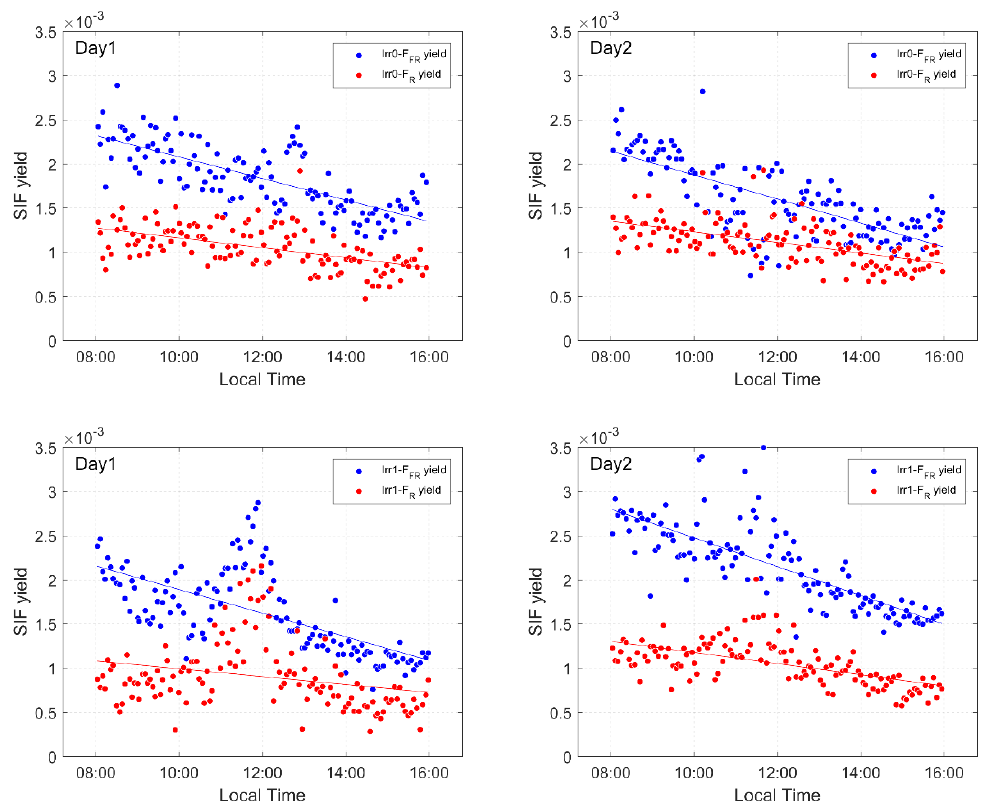
high-temporal-frequency fPAR data in plots Irr0 and Irr1.